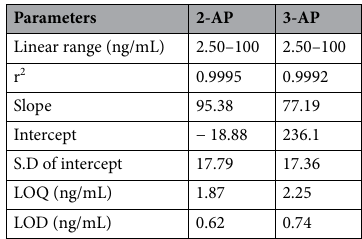
Table 2. Validation parameters for the determination of 2-AP and 3-AP using the proposed